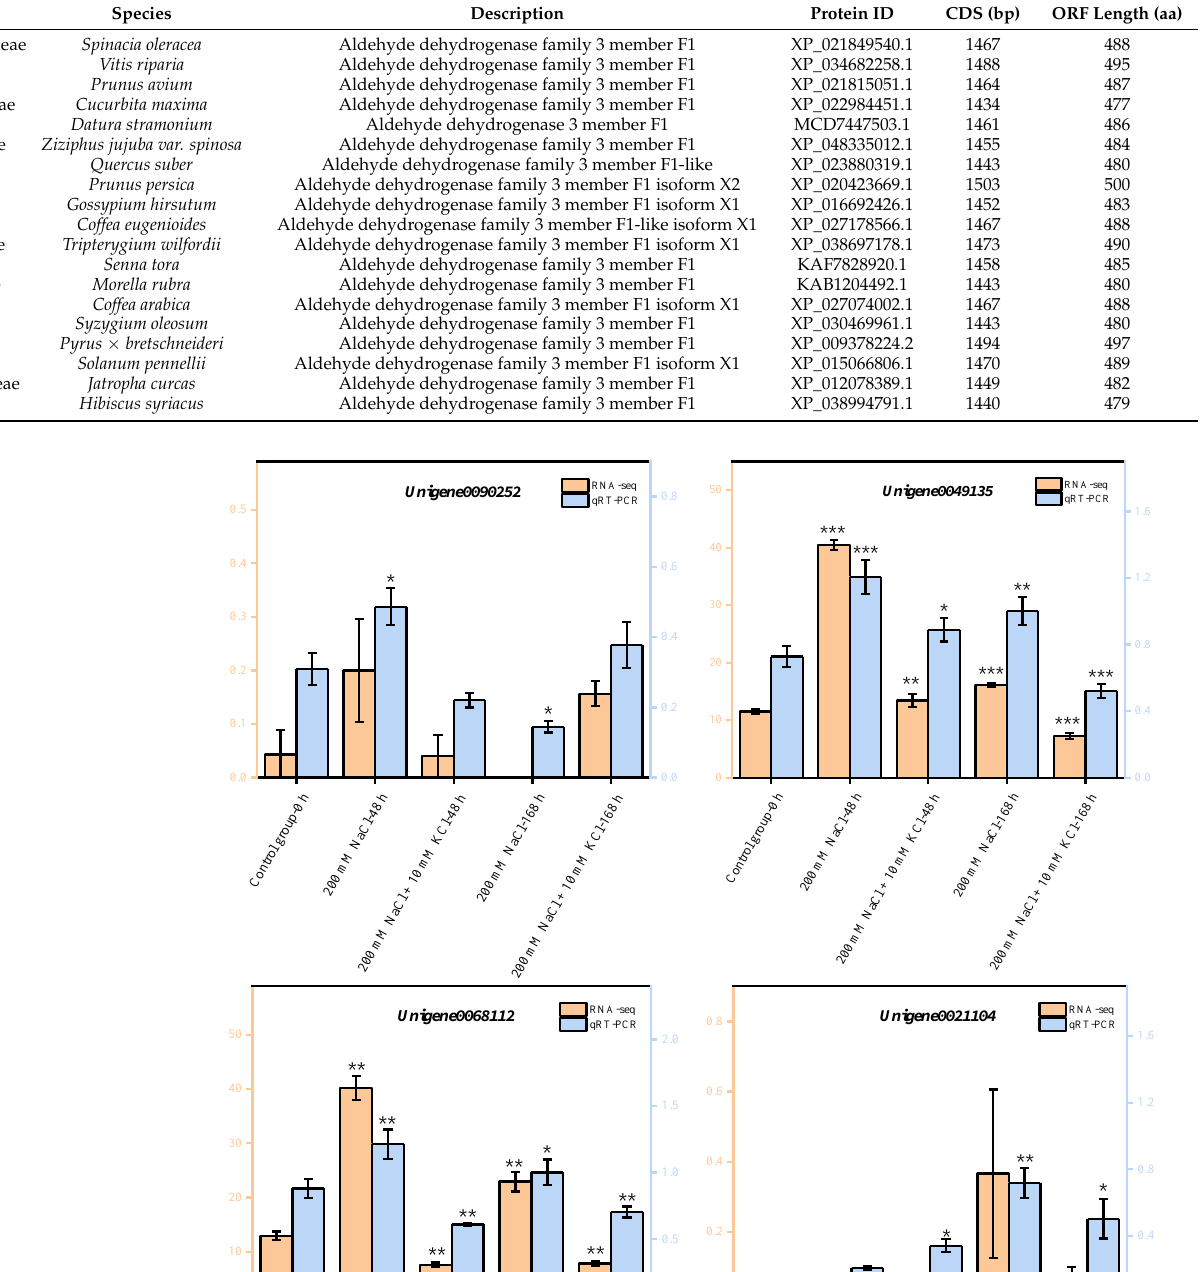
Table 2. Information sheet for the 19 homologous gene species.